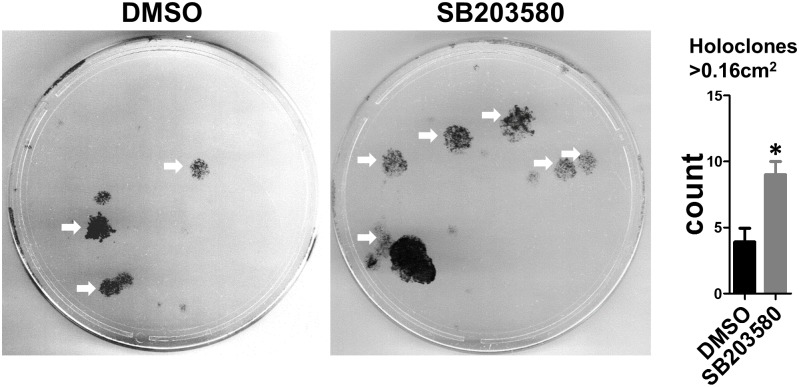
Inhibition of p38 increases holoclone formation.Representative holoclone forming assay of HLEKs following 3day pre-treatment with SB203580 (10μM; p38 inhibitor) or DMSO. SB203580-treated keratinocytes gave rise to significantly more holoclones than DMSO. 200 cells per plate were seeded for each treatment. White arrow: holoclone (colonies >0.16 cm2). T test was performed to calculate significance. *p<0.05.